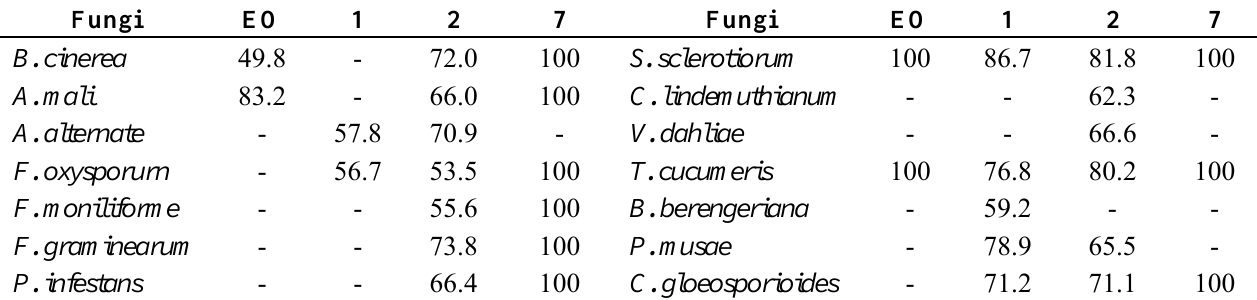
Table 1. Inhibitory ratio (%) of 1 (588 μ M), 2 (272 μ M), 7 (52 μ M) and EO (300 μ g/mL) against plant